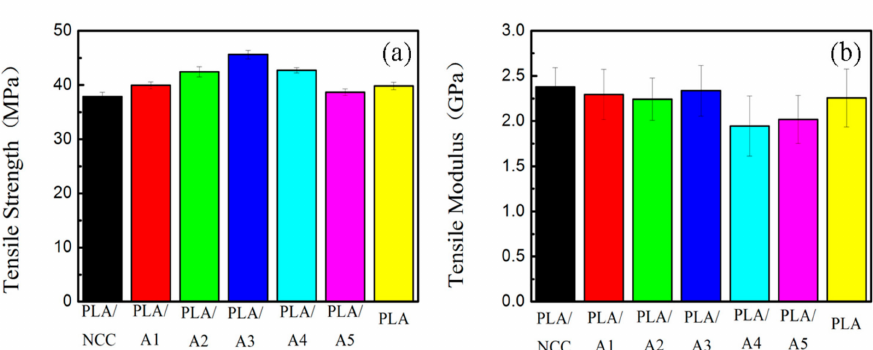
Figure 7. Mechanical properties of PLA / NCC-HAP films with di ff erent ratios of NCC to hydroxyapatite (HAP): ( a ) tensile strength and ( b ) tensile